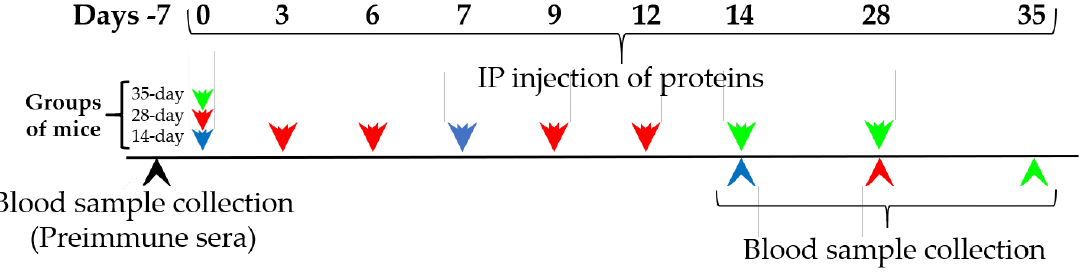
Figure 1. Scheme of sensitization and blood collection. Green, red and blue arrows represent the 35-, 28- and 14-day protocols of sensitization to food proteins respectively. 28- and 14-day protocols of sensitization to food proteins